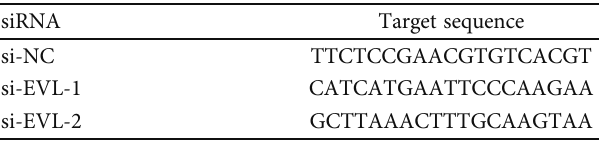
Table 2: The target sequences of the